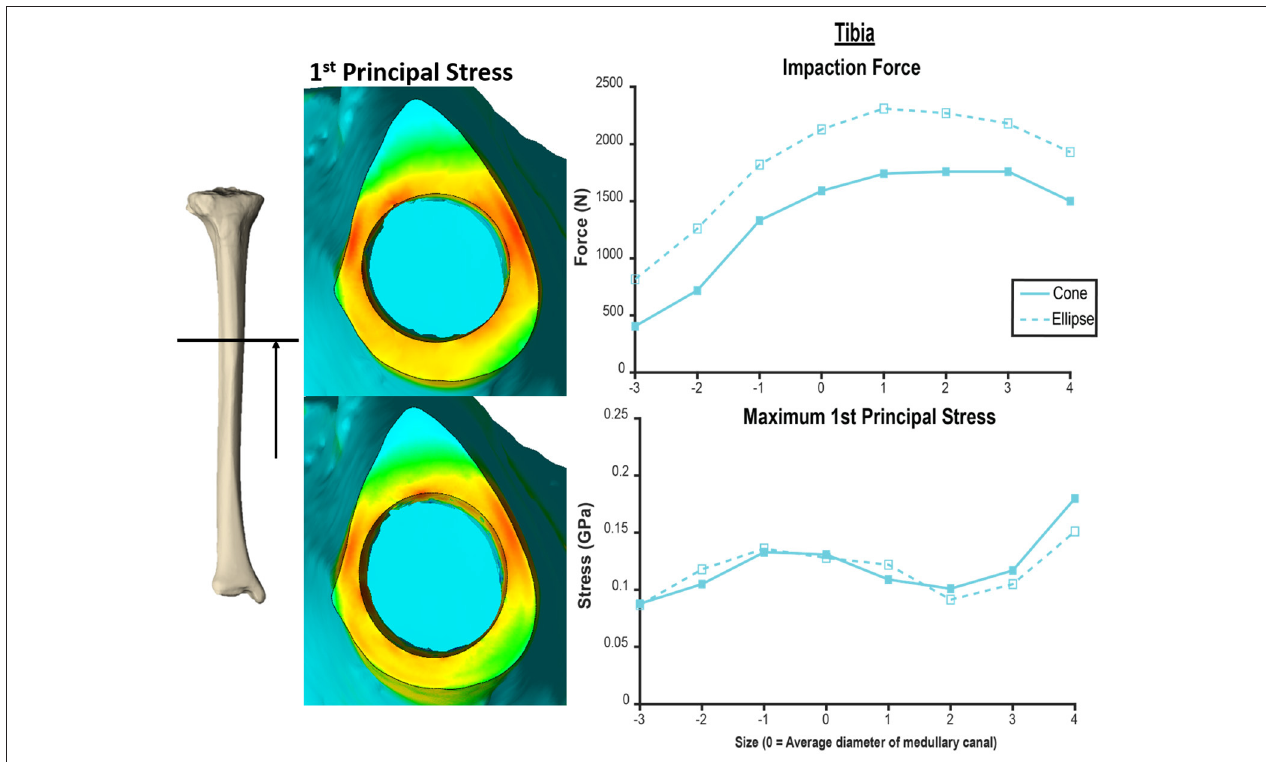
FIGURE 7 | Comparison of tapered endoprosthesis with circular cross-section (left top, right solid) and endoprosthesis with tapered elliptical cross-section (left bottom, right dashed). The elliptical endoprosthesis has a 1-mm larger radius of major and minor diameters. The minor diameter of the ellipse matches the diameter of the circular endoprosthesis. This comparison was conducted on the same tibia bone model. Heat map scale of first principal stress (left) is uniform across both models.